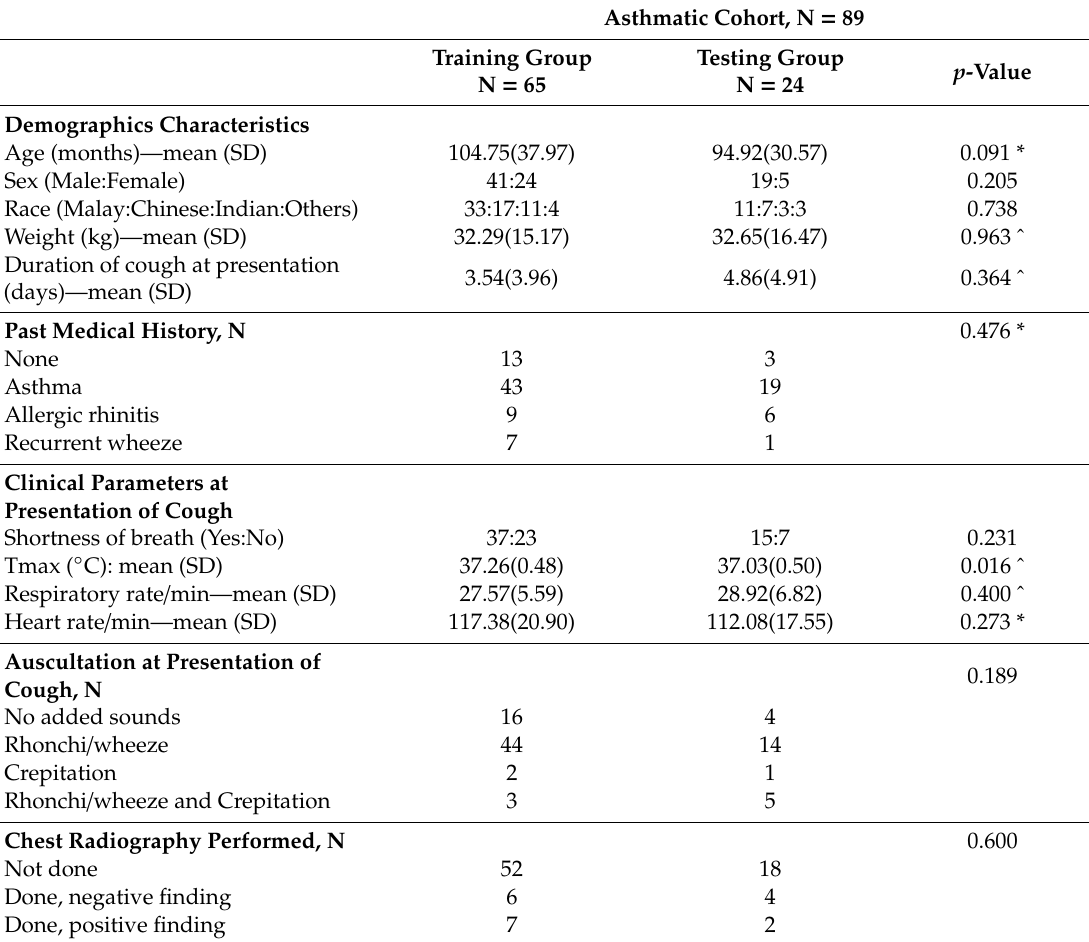
Table 2. Clinical characteristics of the study population in the asthmatic